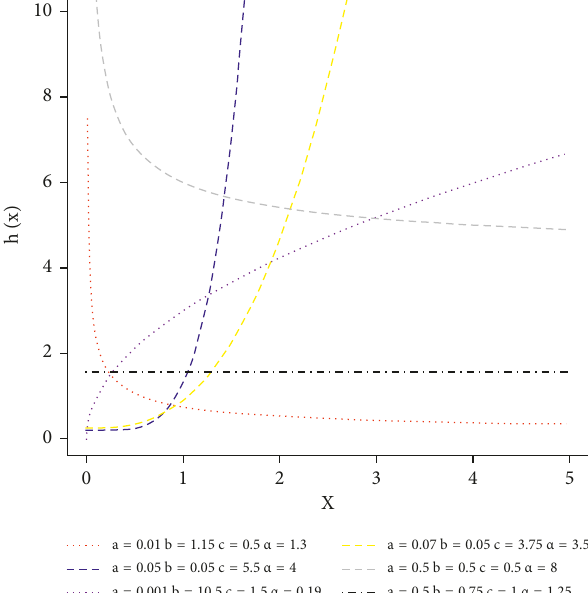
Figure 2: Shapes of the HRF of the ExEW distribution for different values of the